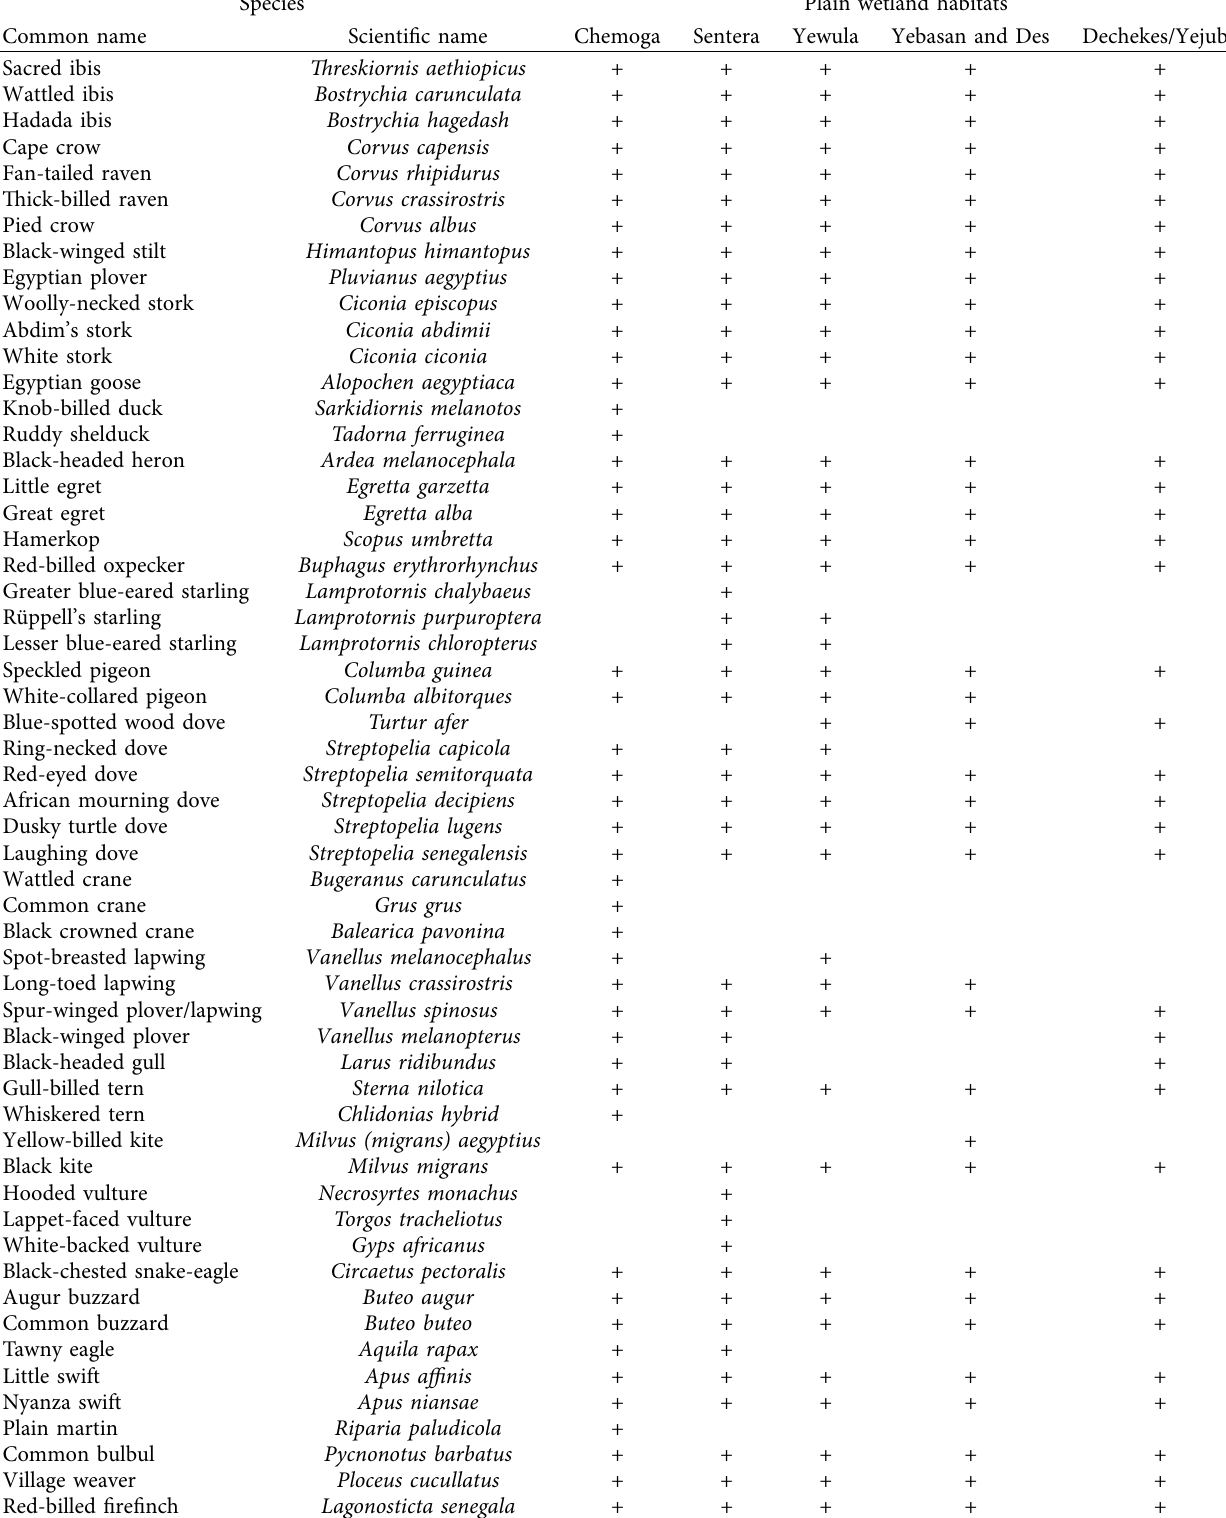
Table 3: Distribution of bird species among the study sites during the study